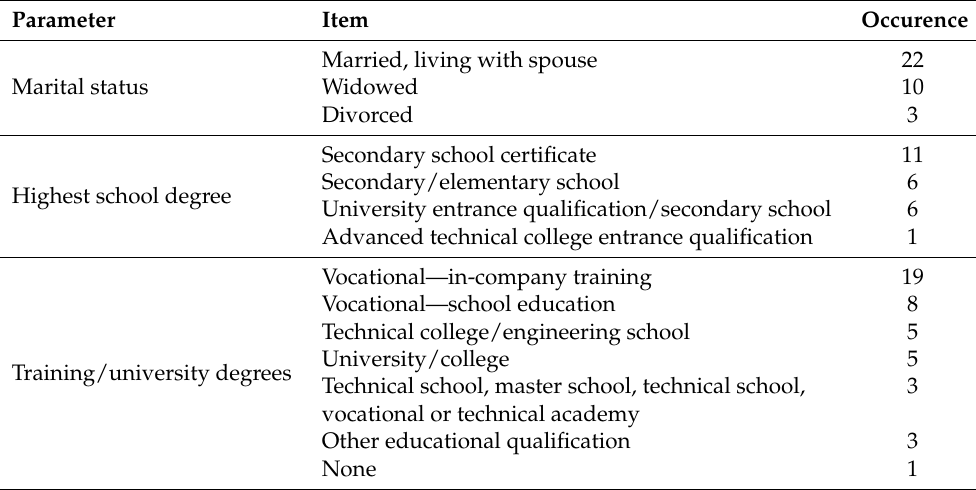
Table 2. Frequency of technical device usages, describing the cohorts technological experience (n =